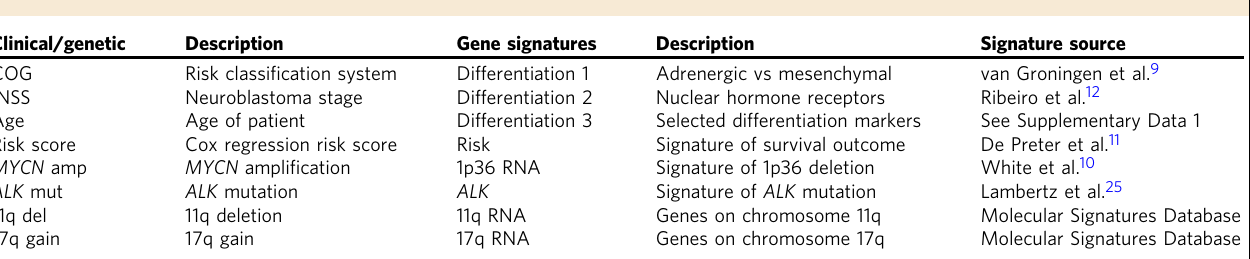
Fig. 1 Integrative discovery of treatments for high-risk neuroblastoma. a Step 1: Data integration. We combined omics data from three cohorts of high- risk neuroblastoma (R2, TARGET and SEQC) to construct risk signatures, which were linked to pharmaco-transcriptomic (L1000) and drug target (STITCH) data, resulting in associations between disease signatures and therapeutic targets. b Step 2: Experimental evaluation. Using tumour cells from high-risk cases, we combine RNA sequencing, cell-based assays, and animal models to con fi rm targets. Table 1 Clinical data and signatures used for target